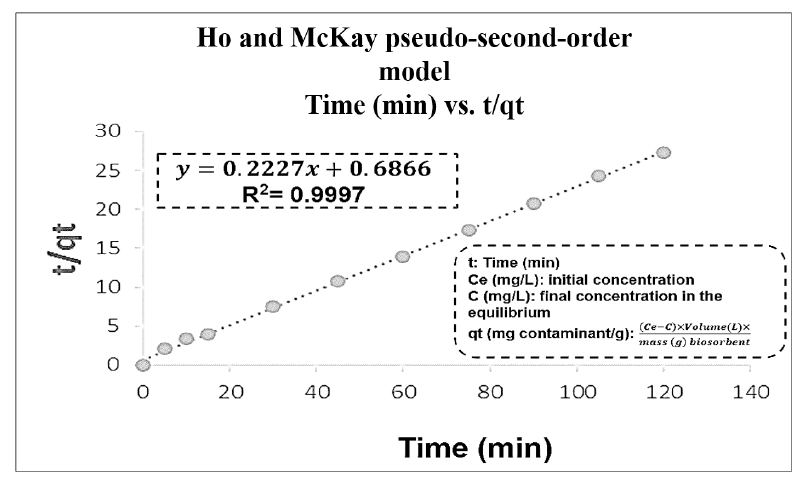
Figure 3. Adsorption kinetics for Pb(II) with CP.